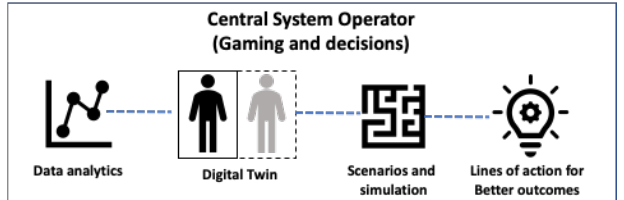
Figure 9. Central System